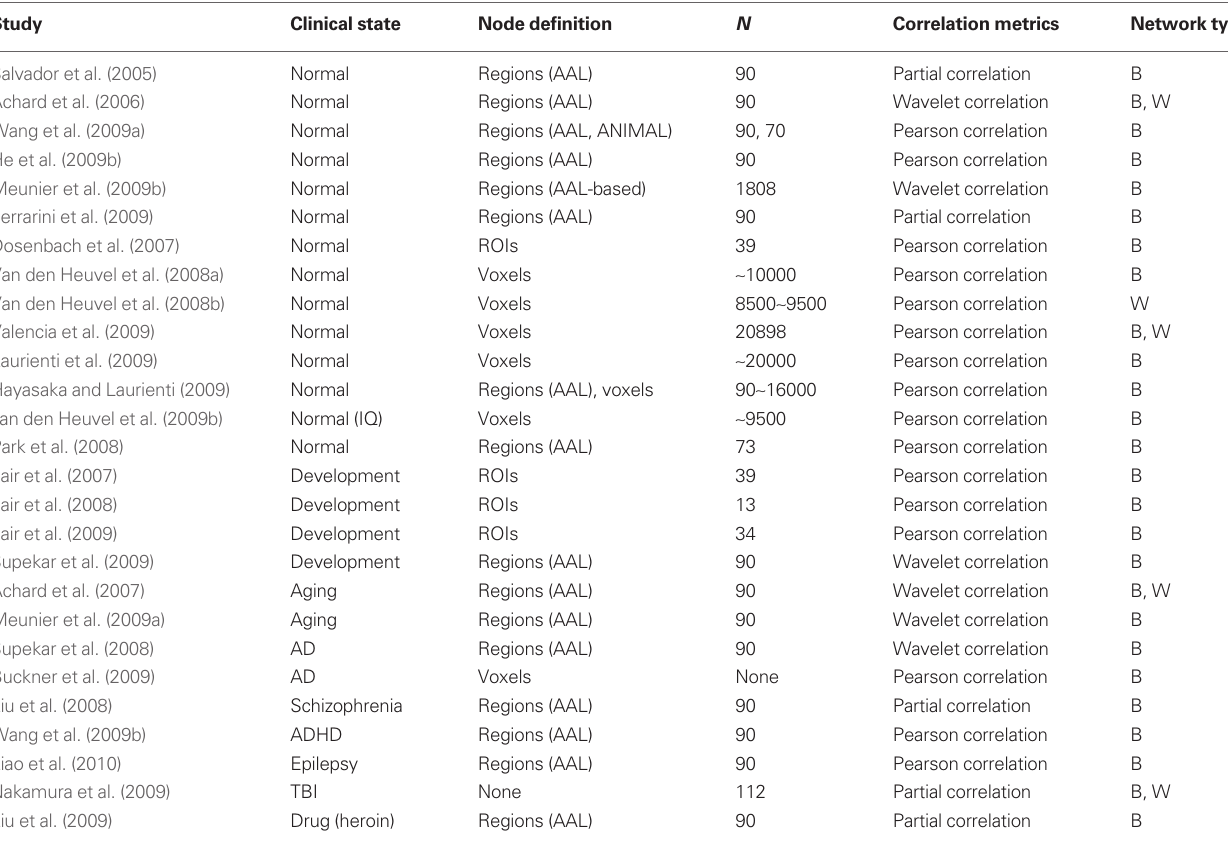
Table 1 | graph-based brain functional network studies by